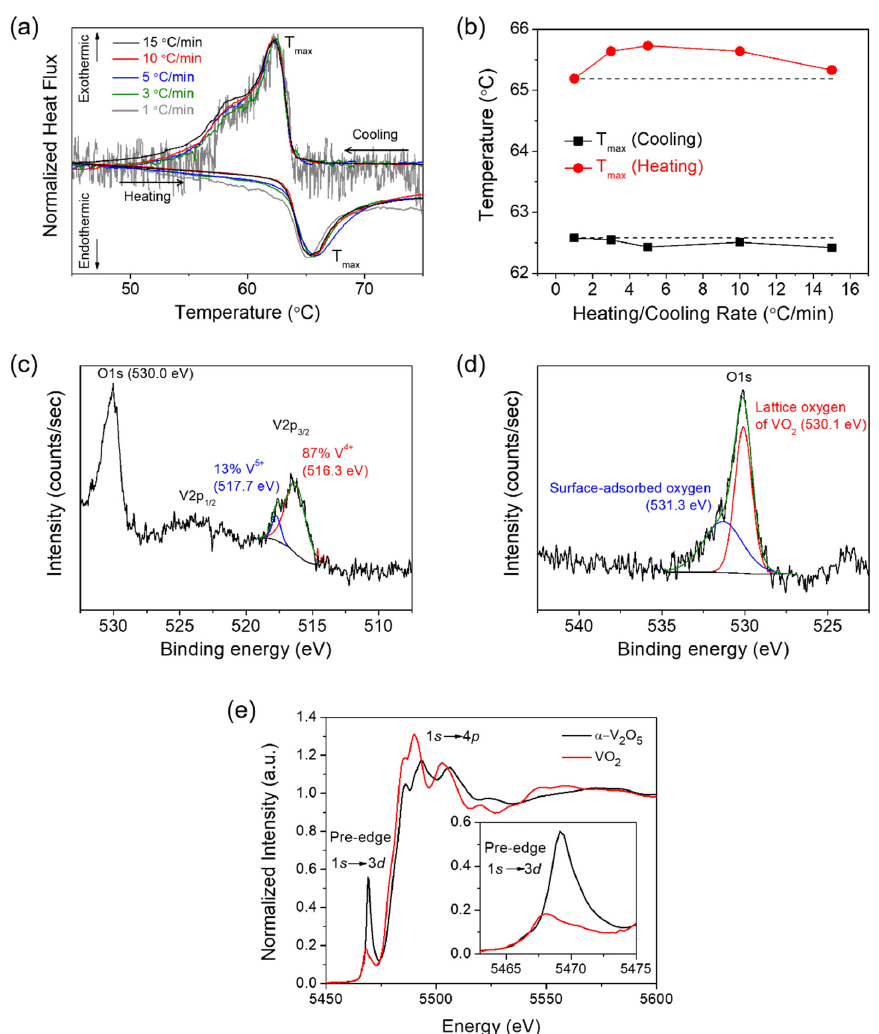
Figure 2. ( a ) Scan rate-dependent DSC results for the VO 2 (M1) nanoparticles formed on carbon fiber paper. Various scan rates with 15, 10, 5, 3, and 1 °C/min were applied. ( b ) Evolution of T max for the VO 2 (M1) nanoparticles formed on carbon fiber paper, as a function of the heating/cooling rate. XPS spectra indicating ( c ) V 2p and ( d ) O 1s binding energies acquired for the VO 2 (M1) nanoparticles formed on carbon fiber paper. The V 2p 3/2 peak in ( c ) and O 1s peak in ( d ) are deconvoluted into respective two sub-peaks. ( e ) Experimental V K-edge XANES spectra acquired for the VO 2 (M1) nanoparticles and α -V 2 O 5 nanowires. The inset indicates the magnification of pre-edge